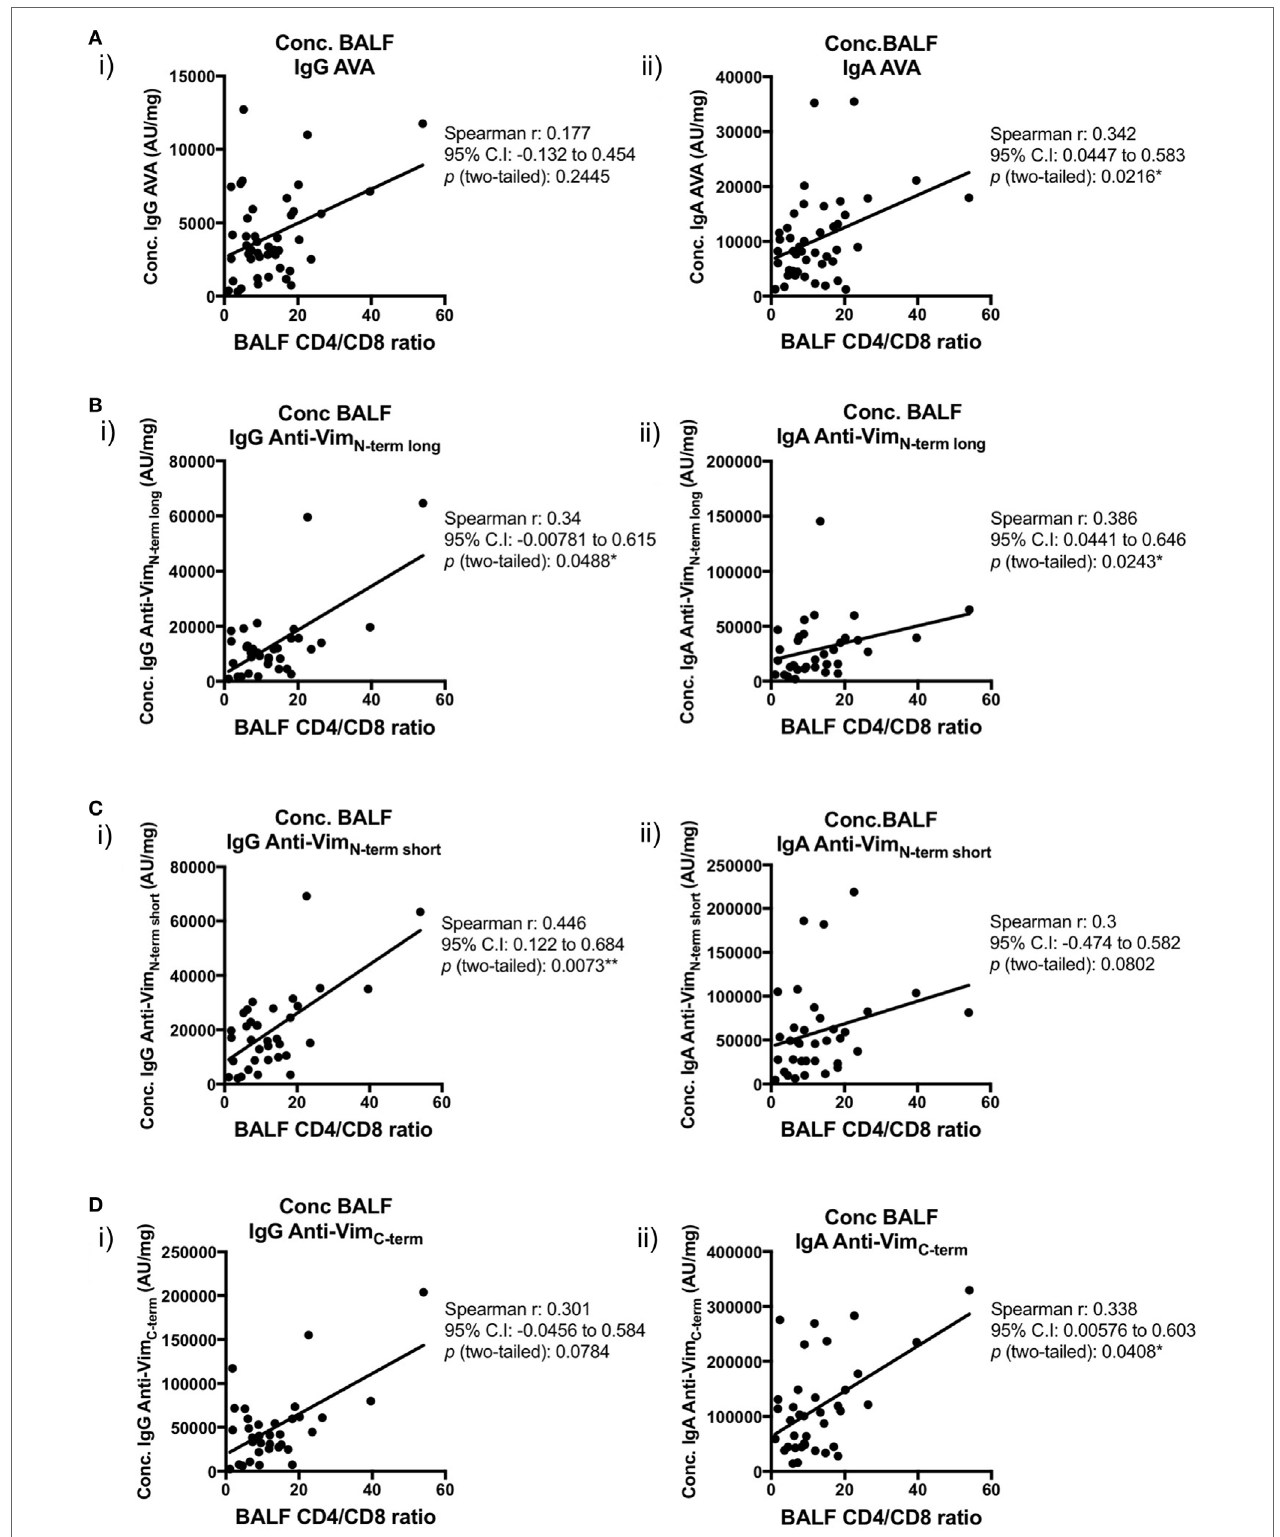
FigUre 7 | Associations of bronchoalveolar lavage fluid (BALF) CD4/CD8 ratio with BALF antibodies to different vimentin truncations in sarcoidosis patients. Spearman’s correlations between (combined HLA-DRB1*03 + and HLA-DRB1*03 − ) patient-matched BALF CD4/CD8 ratios (as determined by flow cytometry) and BALF antibody concentrations (Arbitrary units/mg) to full-length (anti-vimentin antibodies) (a) and truncated vimentin (B–D) for both IgG (i) and IgA (ii). Lines of best-fit are